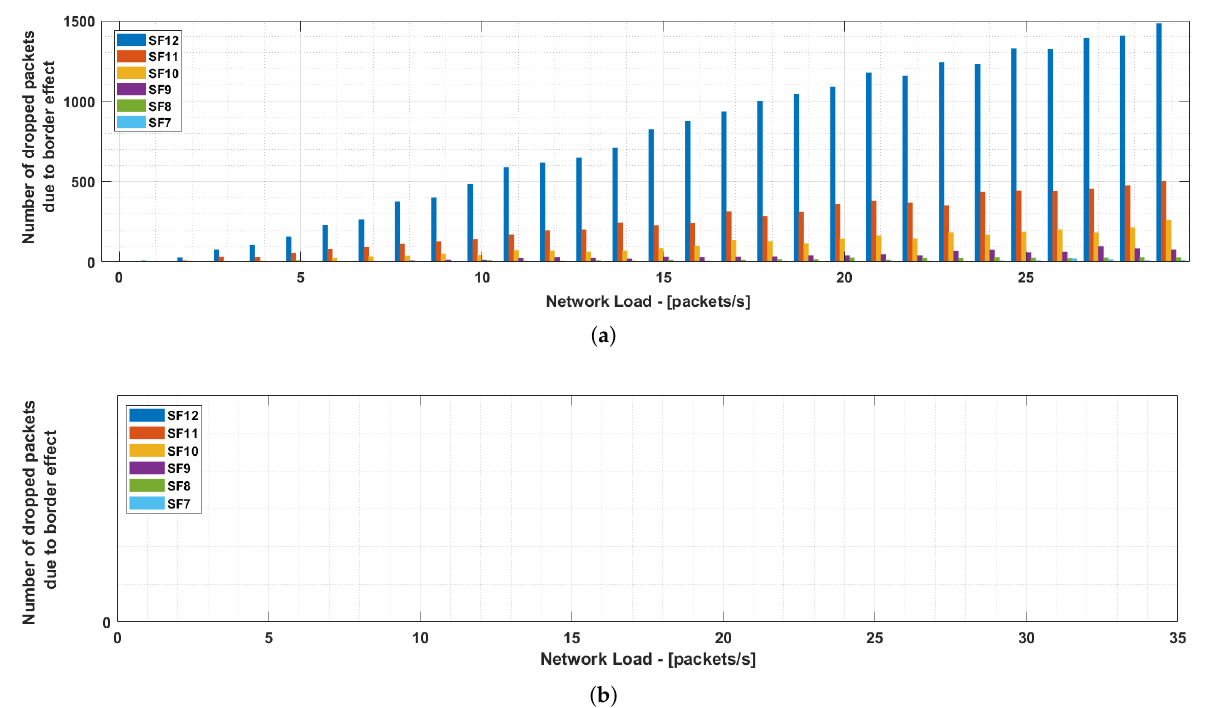
Figure 9. Collisions ( a ) with no border effect check and ( b ) avoiding the border